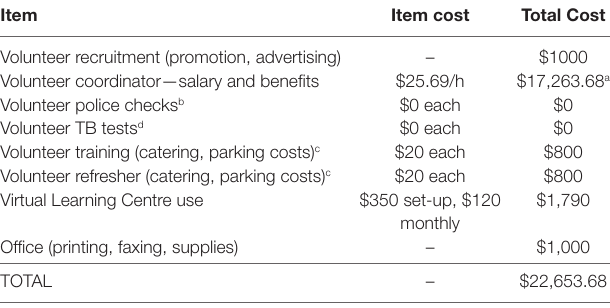
table 4 | One-year cost of a volunteer program (based on 120 clients and 40